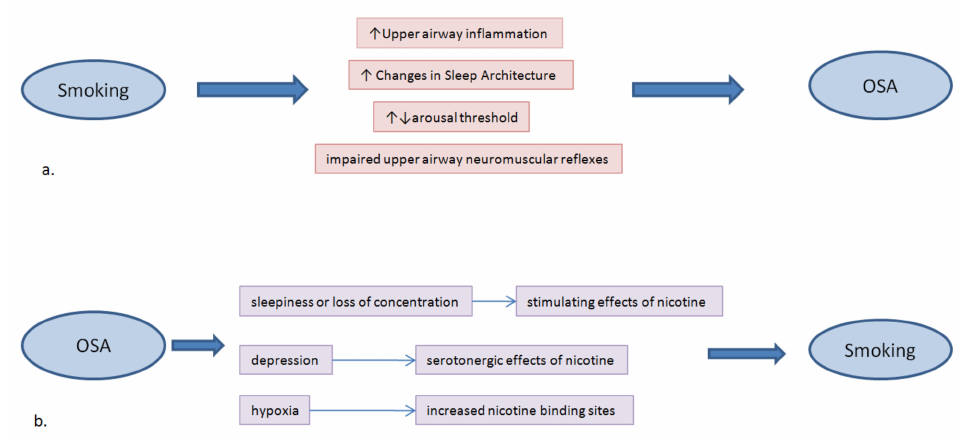
Figure 1. A summary of the bidirectional relationship between Obstructive Sleep Apnea (OSA) and cigarette smoking; ( a ) Mechanisms by which smoking can result in OSA; ( b ) Associations between OSA and